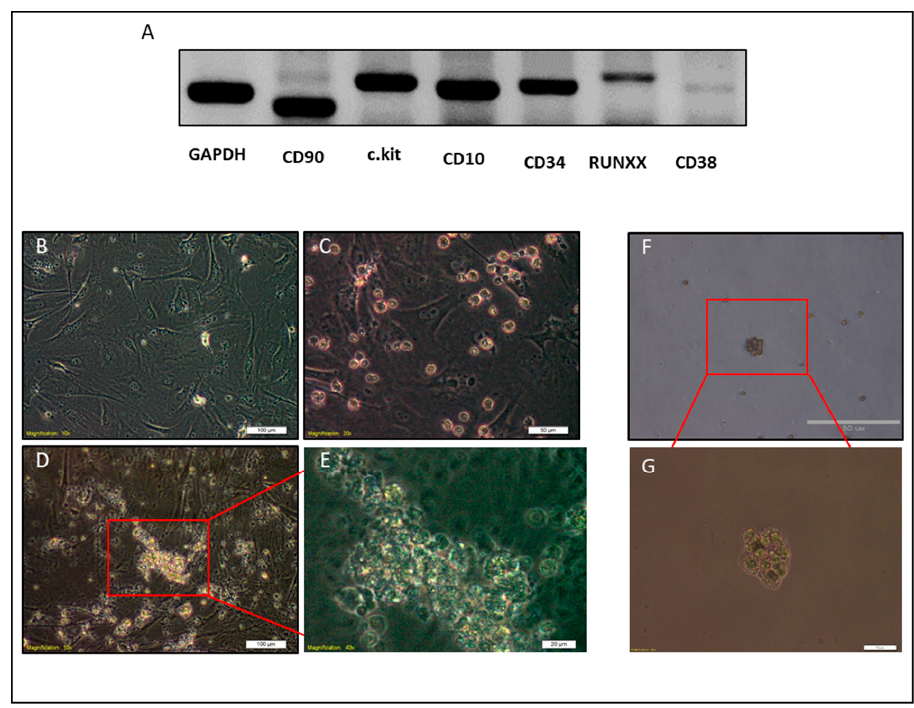
Figure 4. Molecular phenotyping and clonogenic test of NACs. ( A ) Agarose gel electrophoresis of NAC transcripts amplified by RT-PCR. ( B – E ) Representative images of clonogenic test on MEFs, ( B ) MEFs cells before seeding of NACs ( C ) MEFs and NACs cells on the day 1. ( D , E ) Representative images of the colony of NACs after one week of culture on MEFs. F, G) Clonogenic test on semisolid media (methylcellulose). Scale bars represent: ( B , D ) 100 μ m, ( C , F ) 50 μ m, and ( E , G ) 20 μ m.